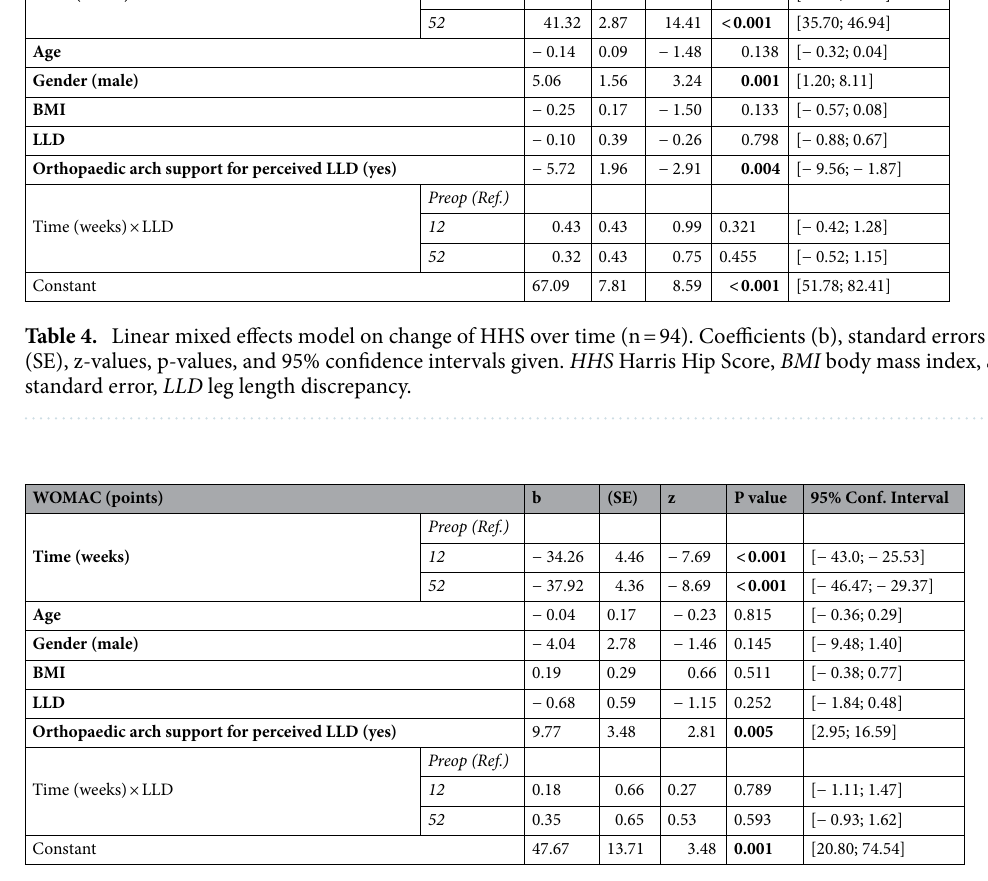
Table 5. Linear mixed effects model on change of WOMAC over time (n = 94). Coefficients (b), standard errors (SE), z− values, p− values, and 95% confidence intervals given. BMI body mass index, SE standard error, LLD leg length